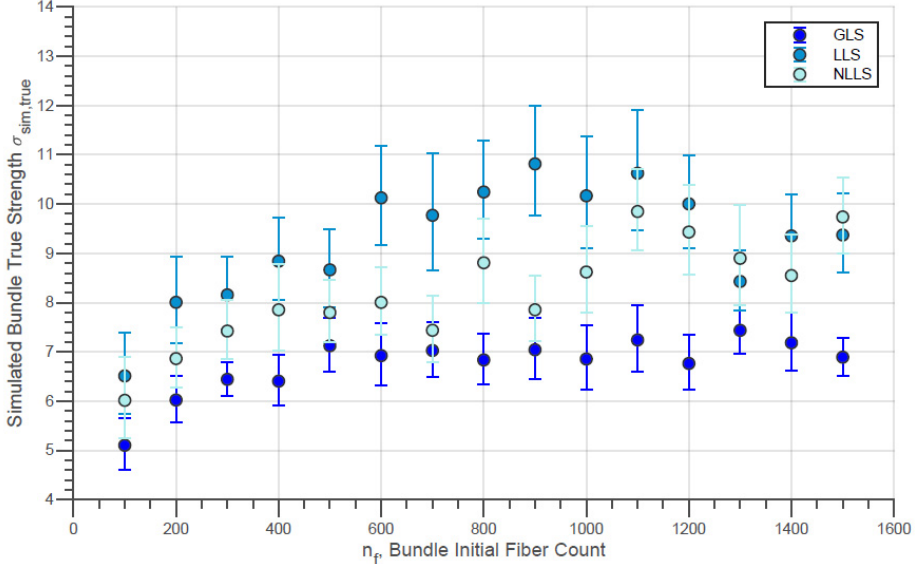
Figure 10. Simulated Characteristic Bundle True Strength against Initial Fiber Count for N610 Fiber Bundles using different load-sharing models.